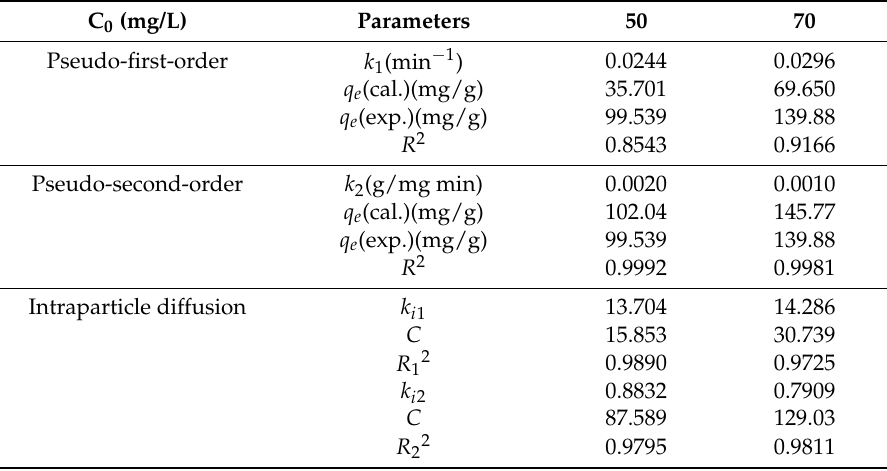
Table 1. The kinetic parameters of adsorption of MB onto SPEN-Al-2.